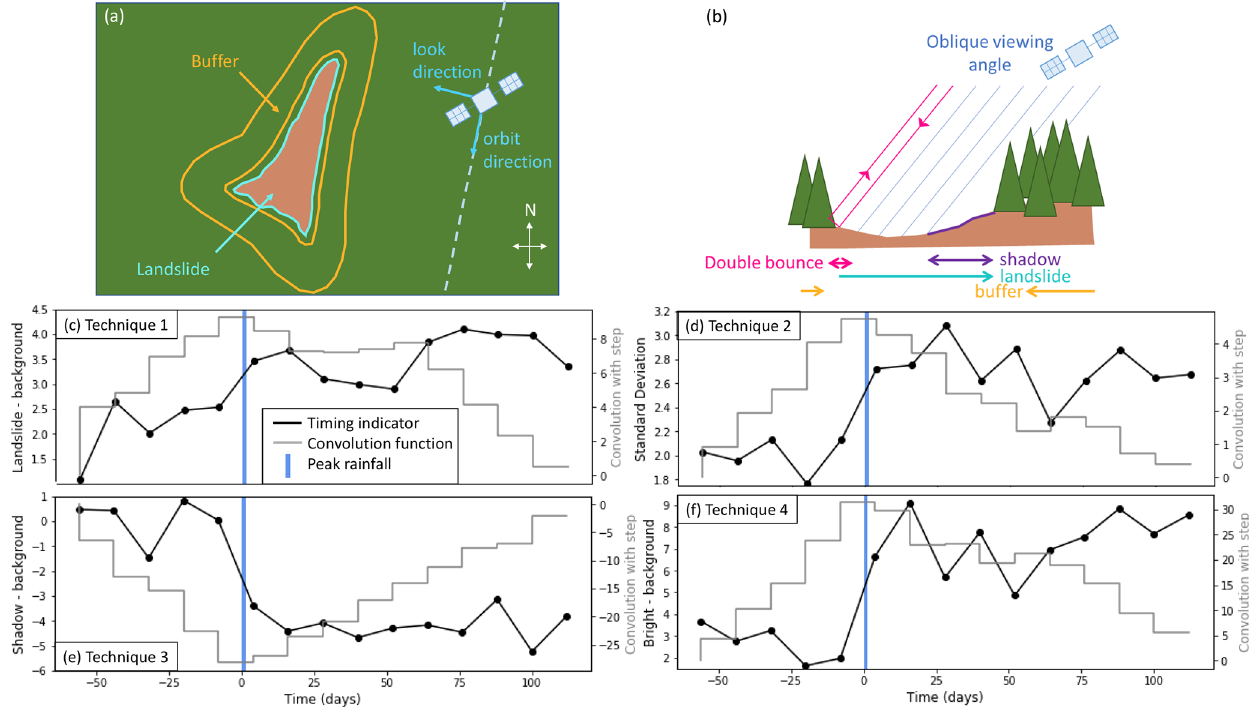
Figure 2. (a, b) Plan and lateral views of a landslide and satellite, showing how background and shadow regions are formed in this study. (c–f) Example time series for a single landslide from the Hiroshima dataset using SAR data from Sentinel-1 Track 090D for Techniques 1–4 respectively (Sect. 2.4). Blue bar shows the duration of the rainfall event during which the landslide was triggered. Grey shows the convolution between the time series and a step